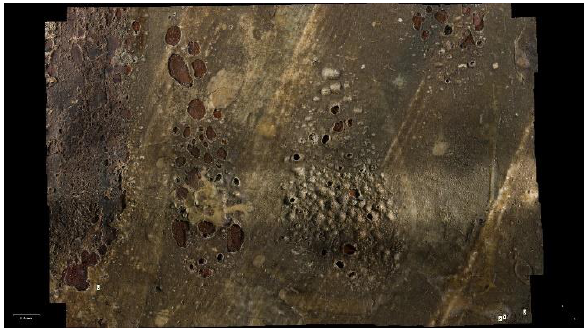
Figure 8. St. Constantine and Helen: area characterized by blisters and flaking. Orthomosaic